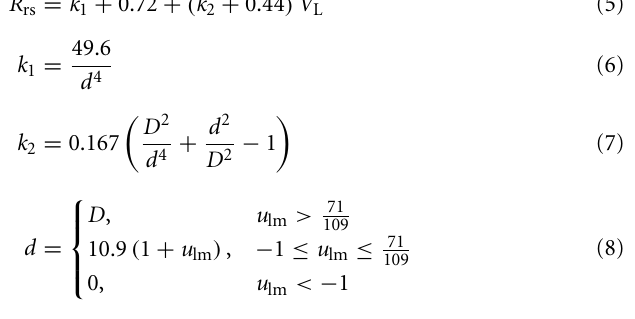
Abdominal pressure on the rib cage Afraction f a of theribcageisexposedtoabdominalpressurerather